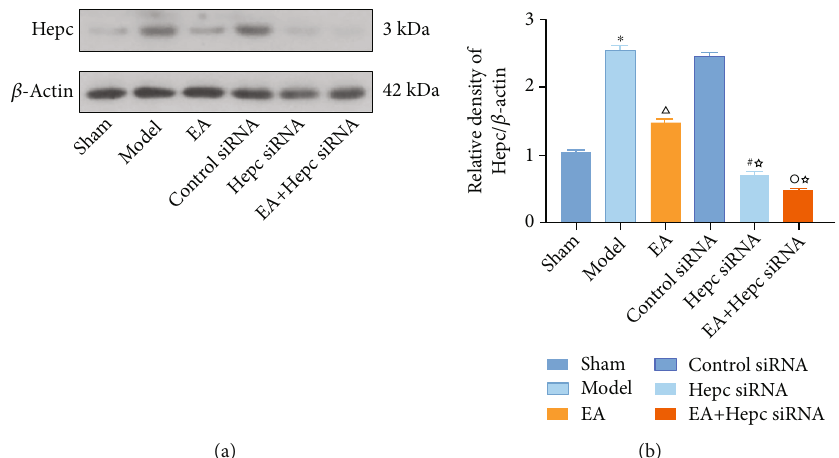
Figure 4: Western blotting results of Hepc protein. Note: ∗ P < 0 : 01 vs. sham group, △ P < 0 : 01 vs. model group, ☆ P < 0 : 01 vs. EA group, # P < 0 : 01 vs. control siRNA group, and ○ P < 0 : 01 vs. Hepc siRNA group.